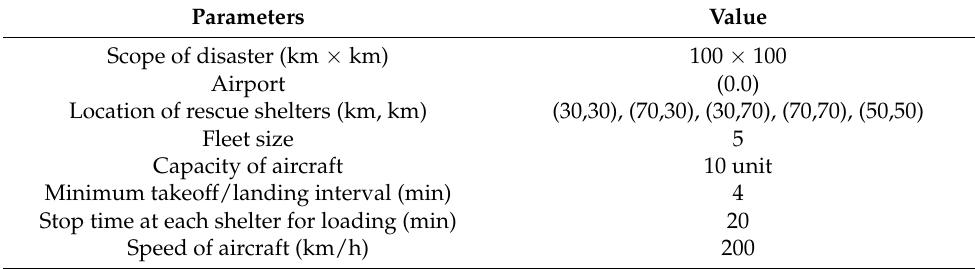
Table 3. Parameters in the simulation.